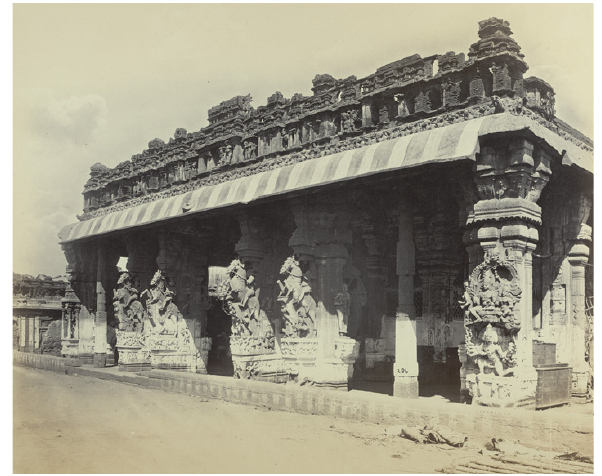
Figure 3. (Western Side of the Pudu Mandapam) The Minakshi Sundareshvara temple. 1868, Edmund David Lyon. ©